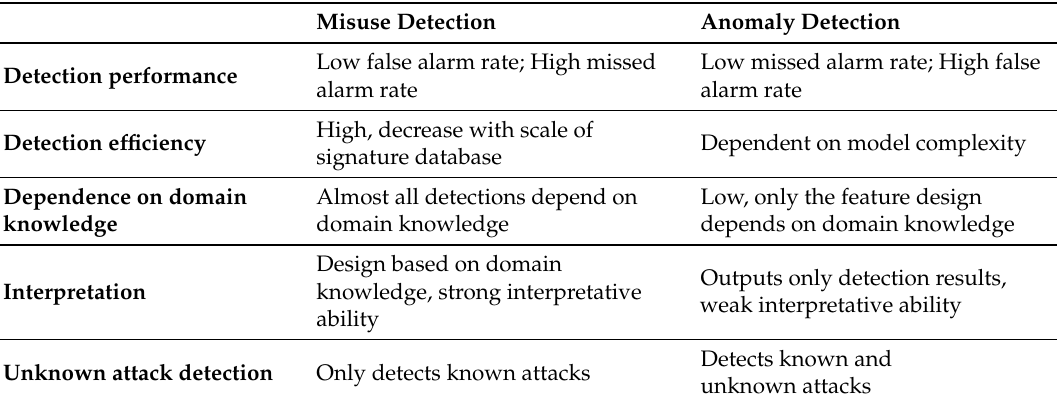
Table 1. Differences between misuse detection and anomaly detection.